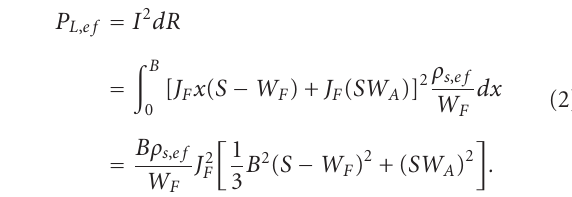
/ (1 − P P MP sh ), where sh is the fractional shading